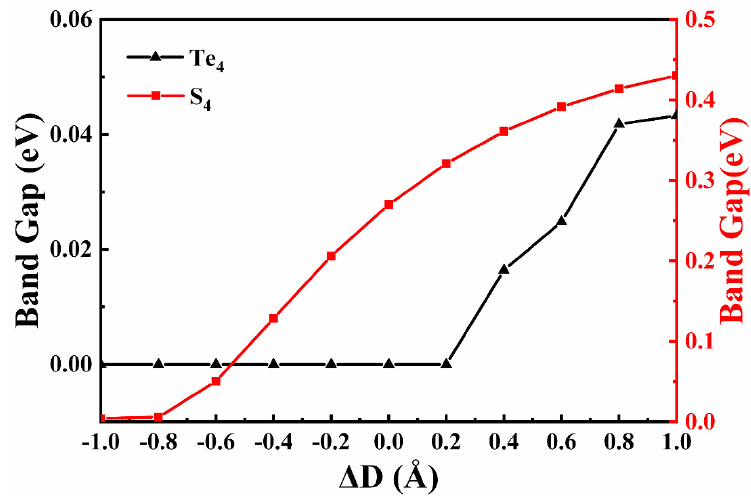
Figure 7. Variations in band gaps of the Te 4 –MoSTe/MoGe 2 N 4 vdWH and S 4 –MoSTe/MoGe 2 N 4 vdWH with the change in interlayer distances. Black and red correspond to Te 4 –MoSTe/MoGe 2 N 4 vdWH and S 4 –MoSTe/MoGe 2 N 4 vdWH, respectively.